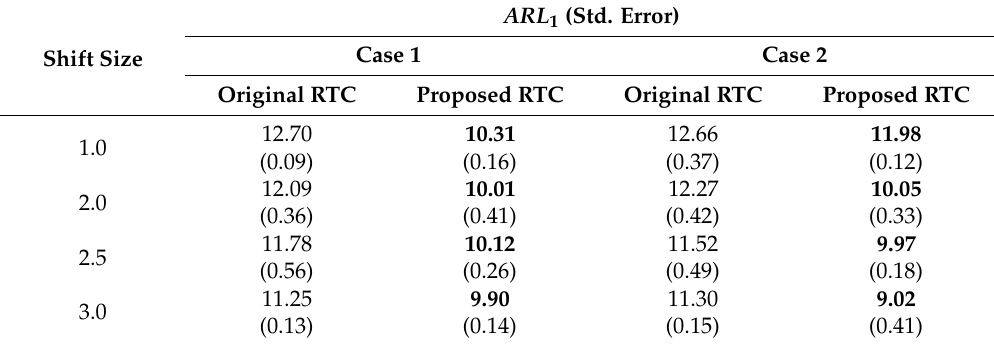
Table 4. Experimental results, dimension size = 100, window size =